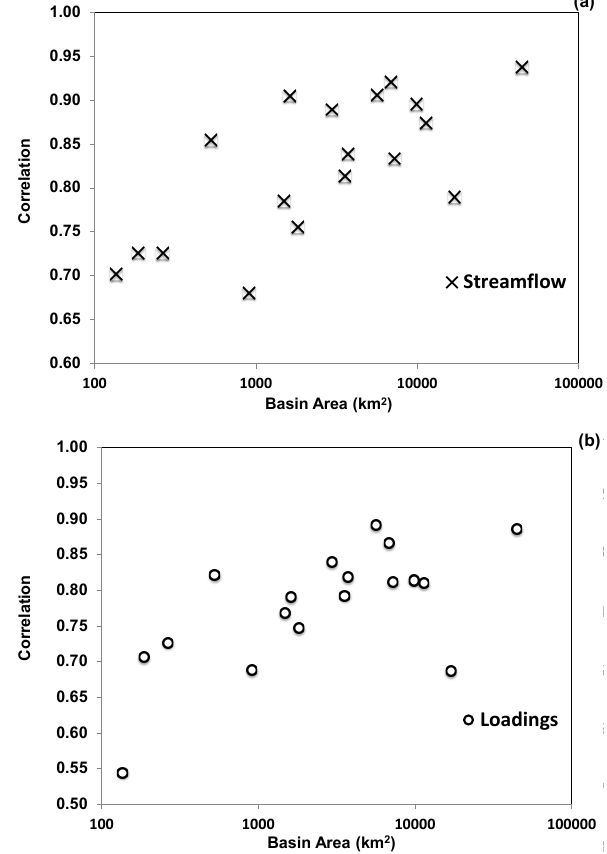
Figure 6. Role of basin scale and drainage area in forecasting ob- Figure 6: Variability in Skill on predicting observed streamflow (a) and TN loadings (b) as a 59 served (a) streamflow and (b) TN loadings provided in the WQN database for the 18 function of drainage area. 60